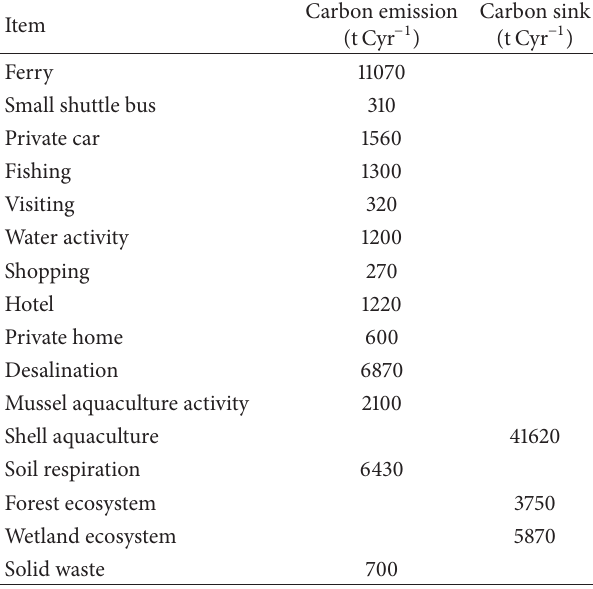
Table 6: General result of the carbon cycle model for Gouqi Island with the data of